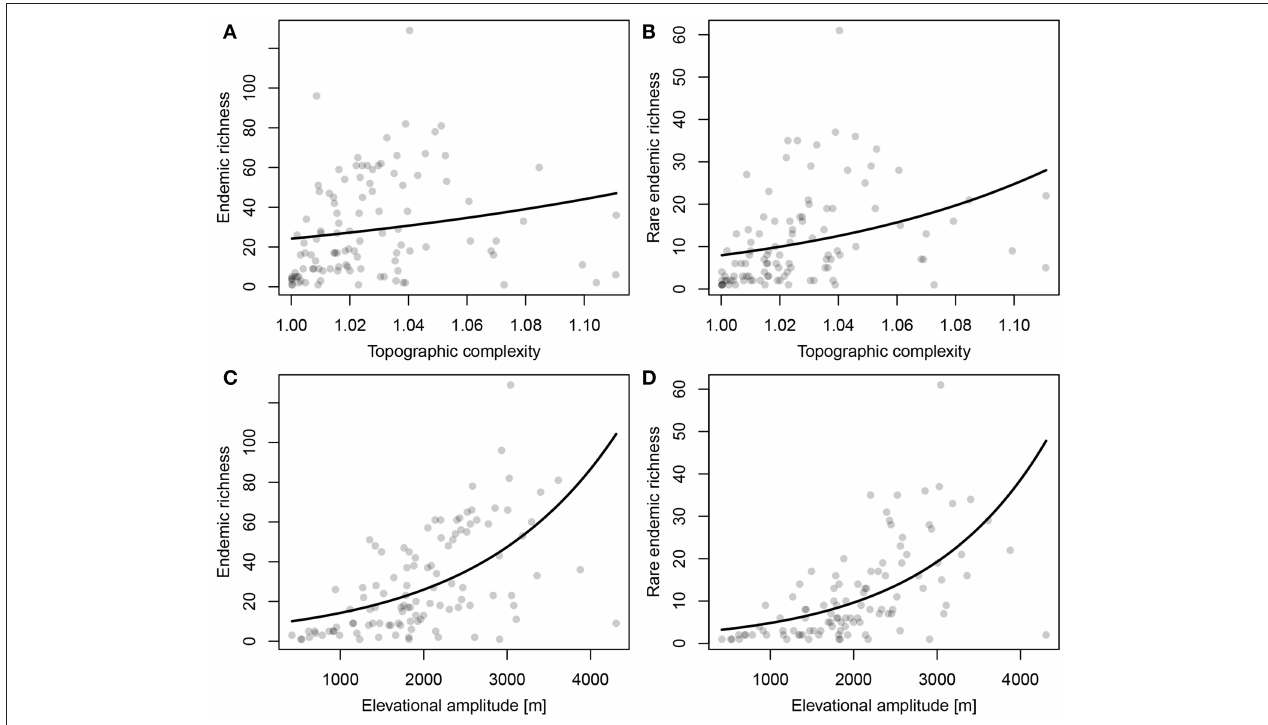
FIGURE 5 | Relationships between (A,C) Endemic Richness (ER) and (B,D) Range-restricted Endemic Richness (RER) per raster-cell and (A,B) topographic complexity and (C,D) elevational amplitude.